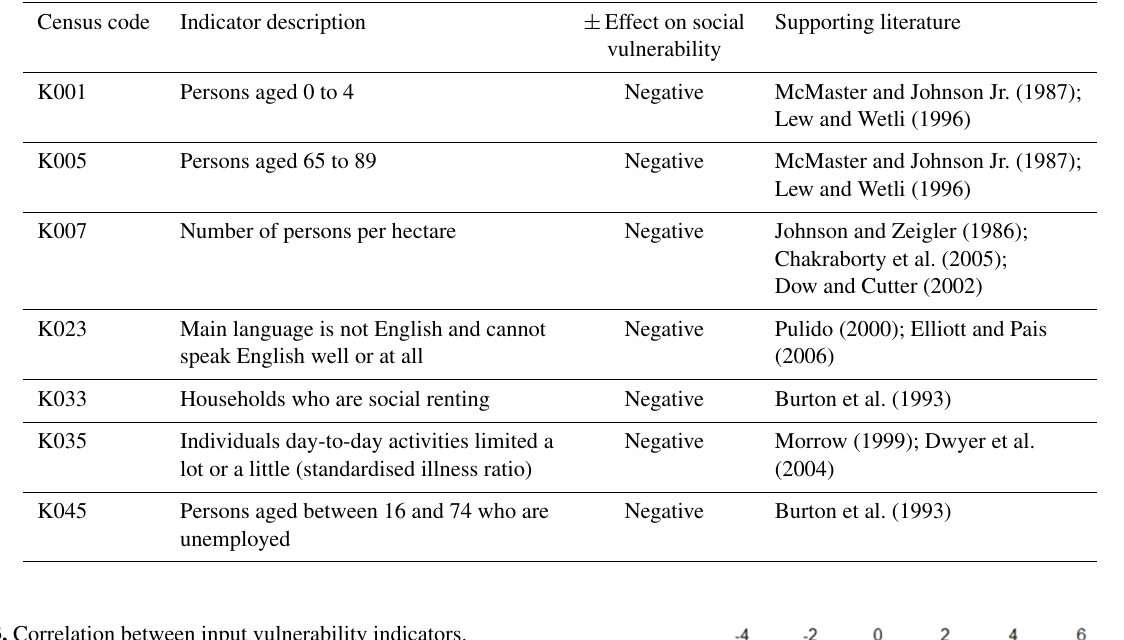
Table 3. Correlation between input vulnerability indicators.